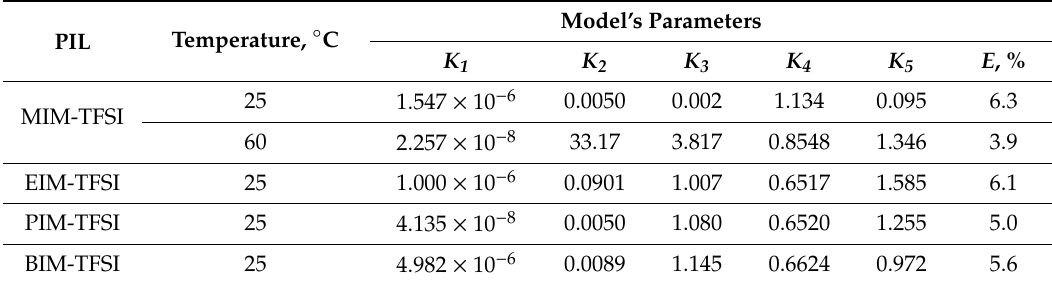
Table 4. The D’Arcy and Watt model parameters (Equation (9)) and the mean relative deviation modulus E (Equation (8)) for synthesized